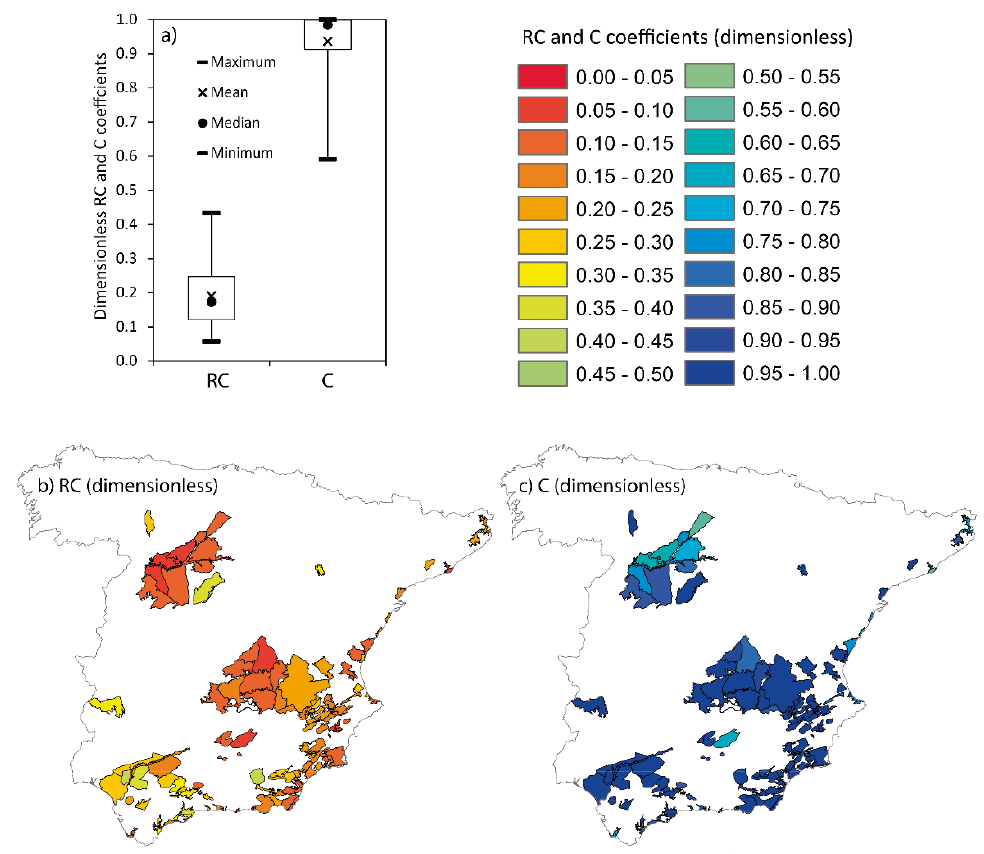
Figure 10. Box-Whisker ( a ) and maps of the of the “recharge coefficients” (RC) ( b ) and the “effective recharge coefficient (C)” ( c ) in the GW bodies at risk [1].